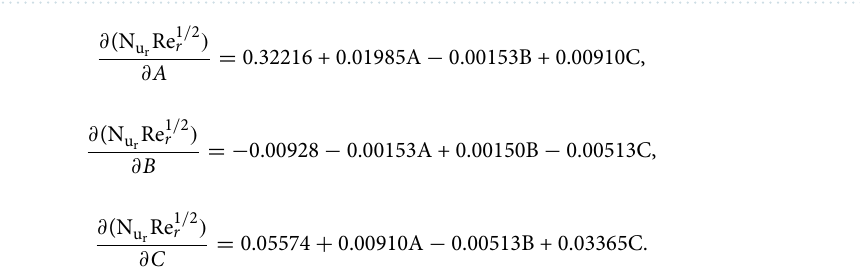
Figure 8. The residual normal quantile–quantile (Q–Q) plot for C fr Re 1 / 2 C g θ Re r is presented in the upper right panel for Nu r Re − ∗